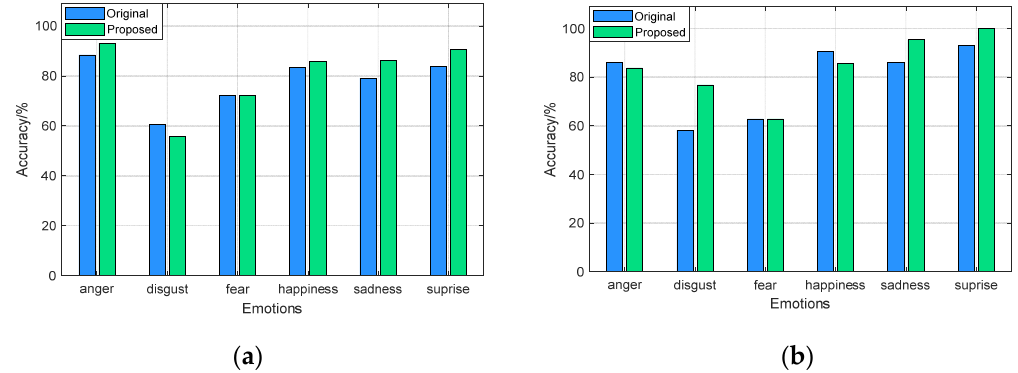
Figure 6. Recognition results on eNTERFACE’05: ( a ) SVM classifier; ( b ) RF classifier.